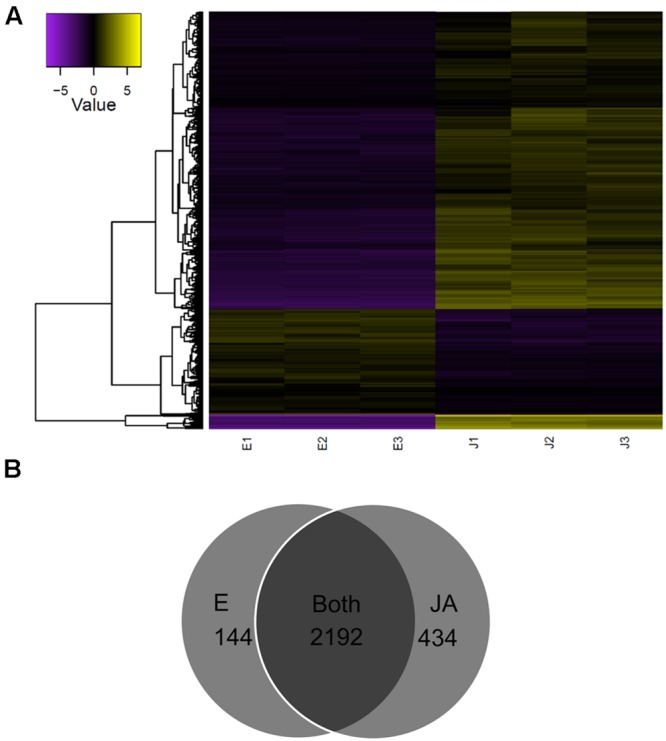
Identification of JA-responsive genes in pokeweed. (A) Heat map of expression values (log2FPKM, median-centered) of the top differentially expressed transcripts (FDR < 0.001, FC ≥ 4). (B) Venn diagram depicting treatment-specific expression patterns of transcripts in (A).